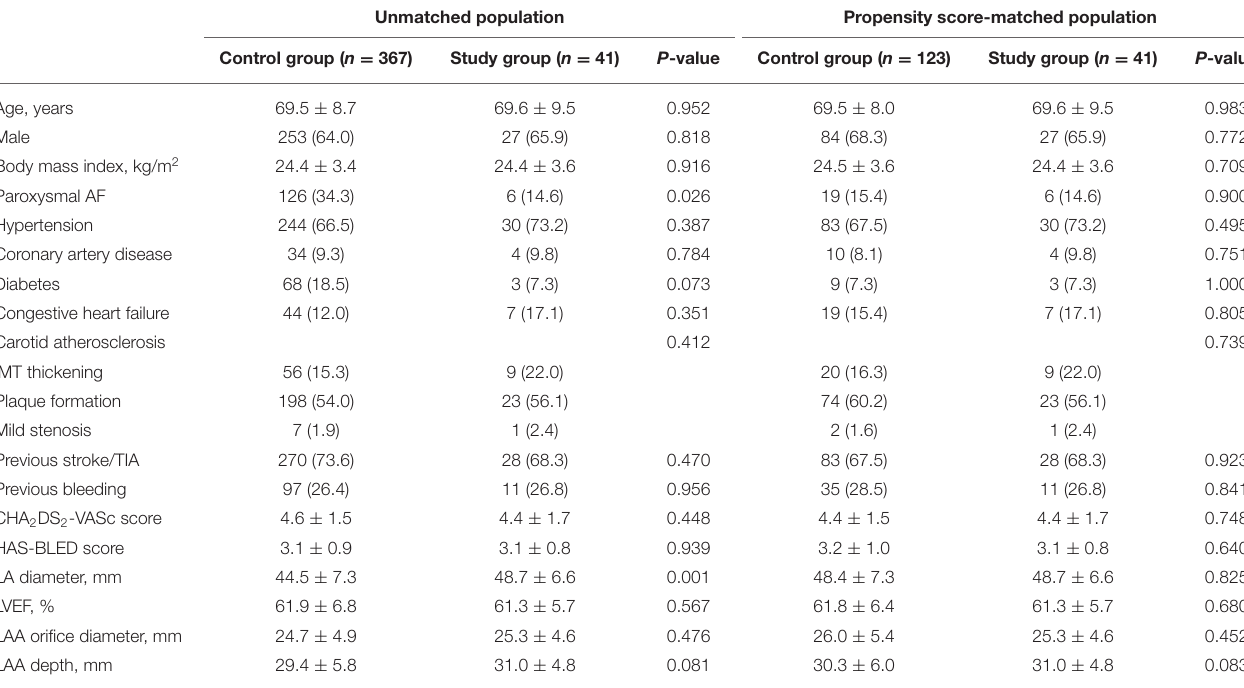
TABLE 1 | Baseline characteristics of the study